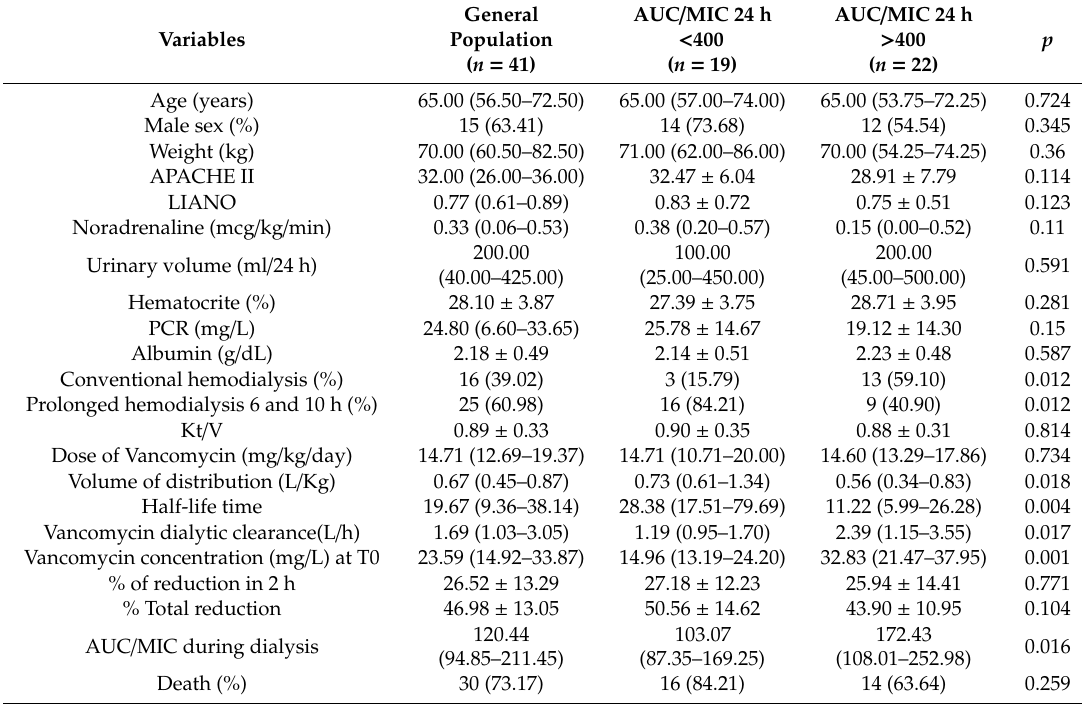
Table 5. General characteristics of the population according to the area under the curve/minimum inhibitory concentration of Vancomycin.